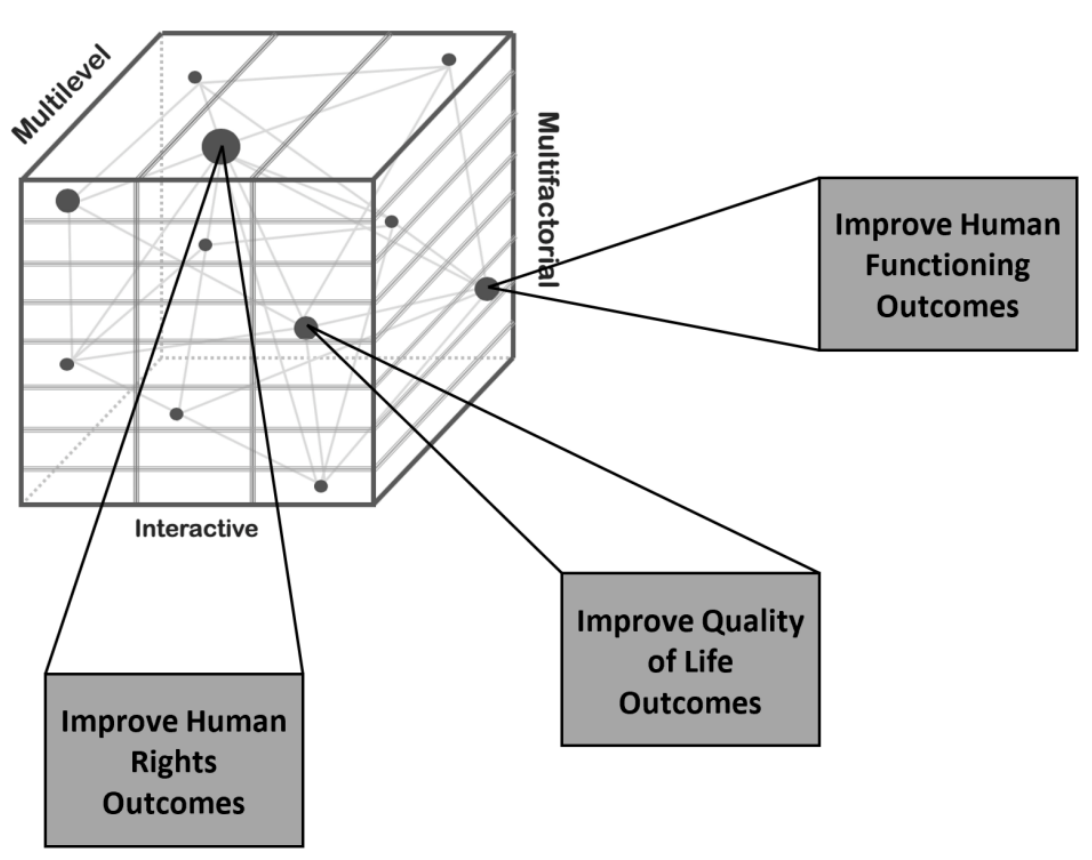
Figure 1. A Multidimensional Model of Context.